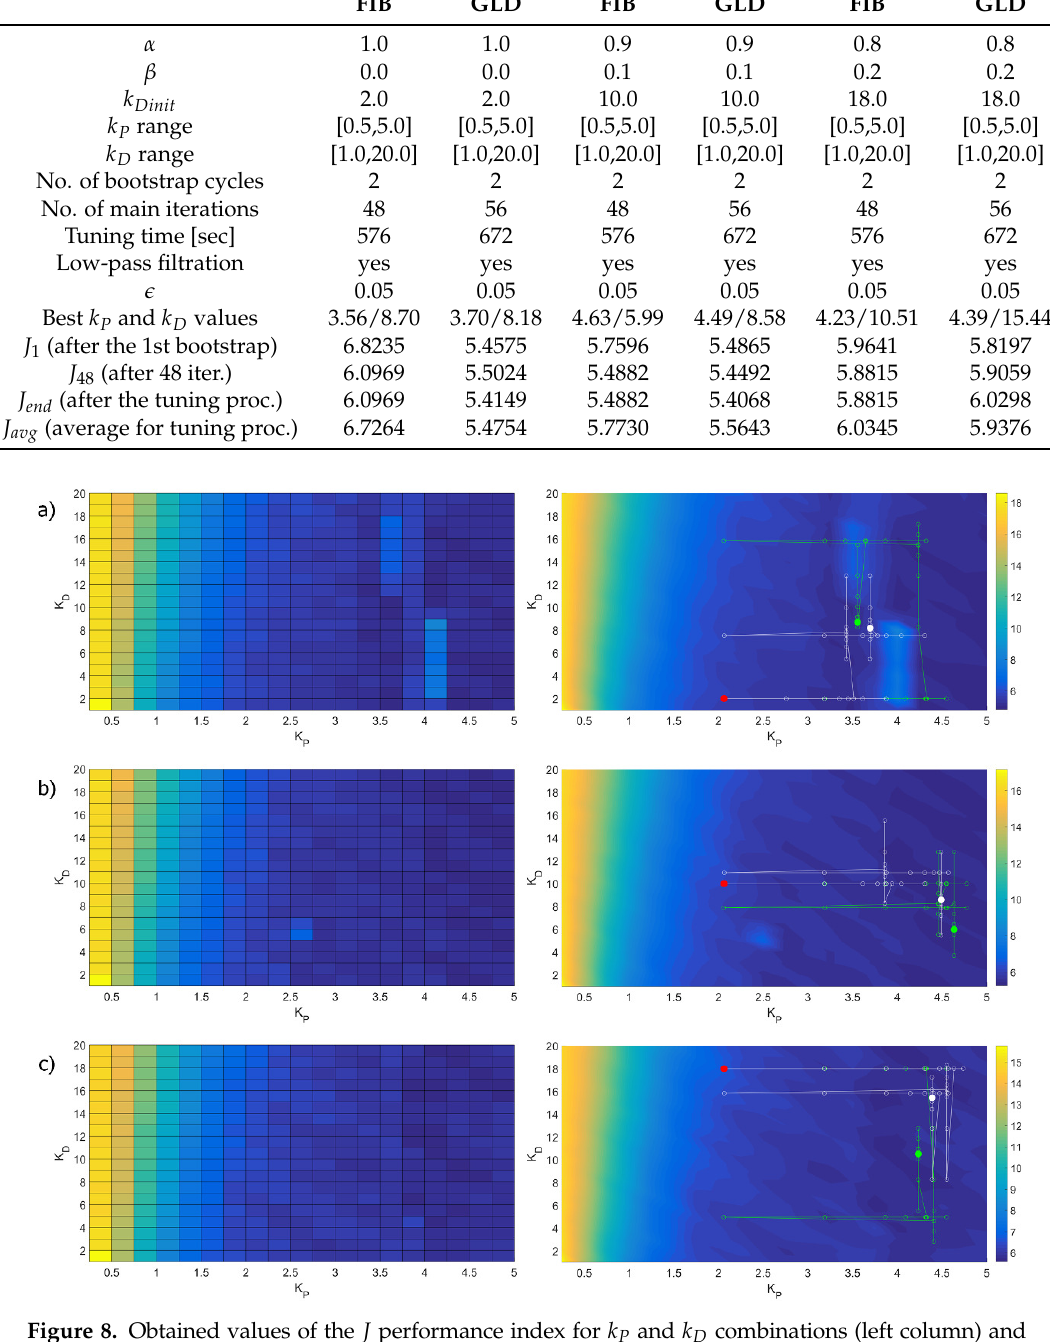
Figure 8. Obtained values of the J performance index for k P and k D combinations (left column) and J = f ( k P , k D ) approximations (right column) for: ( a ) α = 1.0, β = 0.0, ( b ) α = 0.9, β = 0.1, ( c ) α = 0.8, β = 0.2. FIB (green) and GLD (white) tuning results for: ( a ) k Dinit = 2, ( b ) k Dinit = 10, ( c ) k Dinit = 18 (marked in